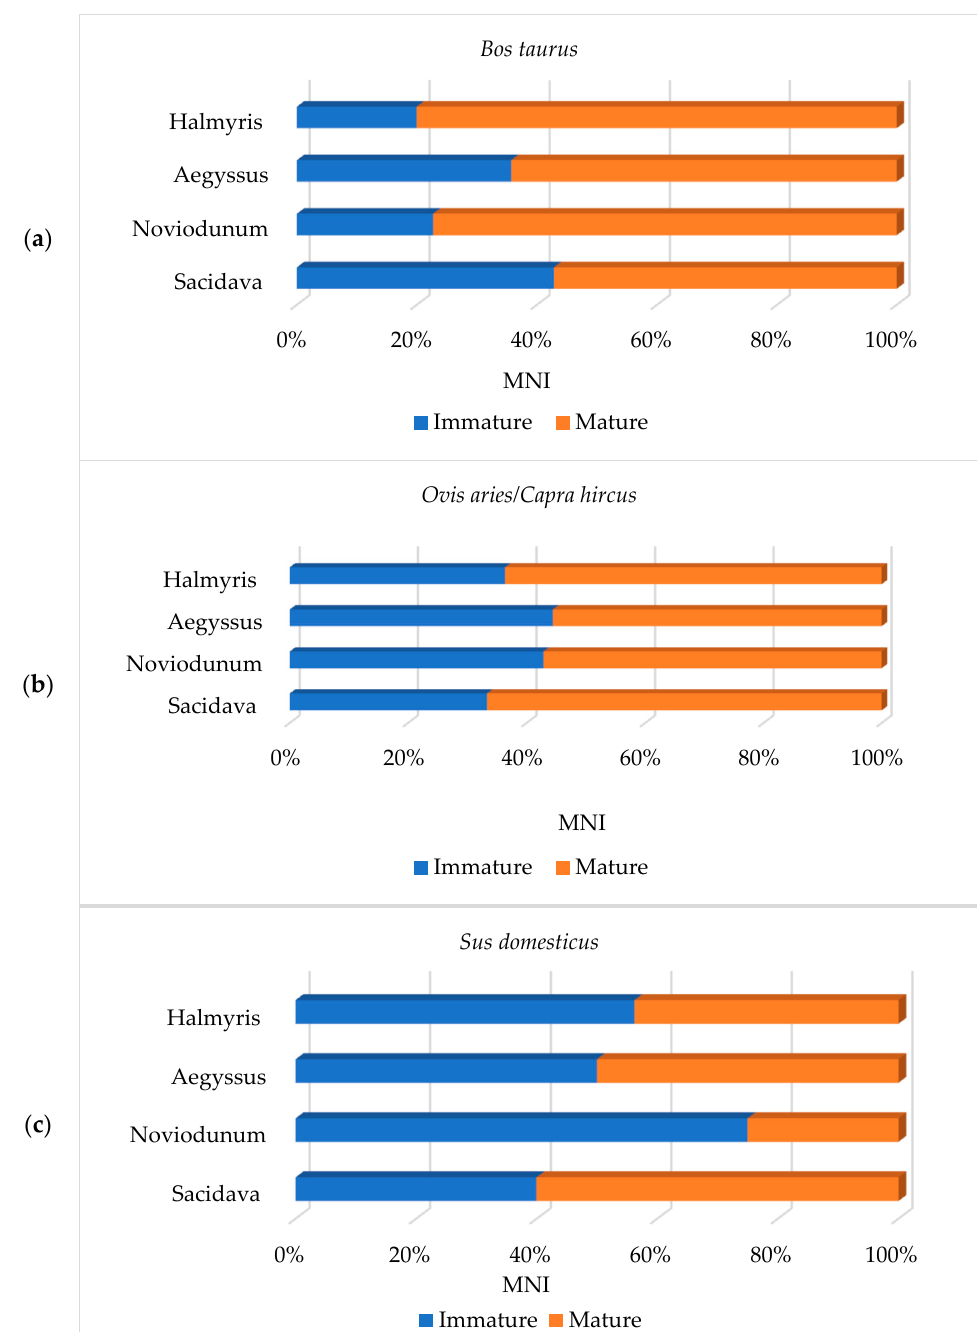
Figure 6. Proportions between immature and mature estimated individuals: ( a ) Bos taurus (cattle); ( b ) Ovis aries/Capra hircus (sheep/goat); ( c ) Sus domesticus (pig).